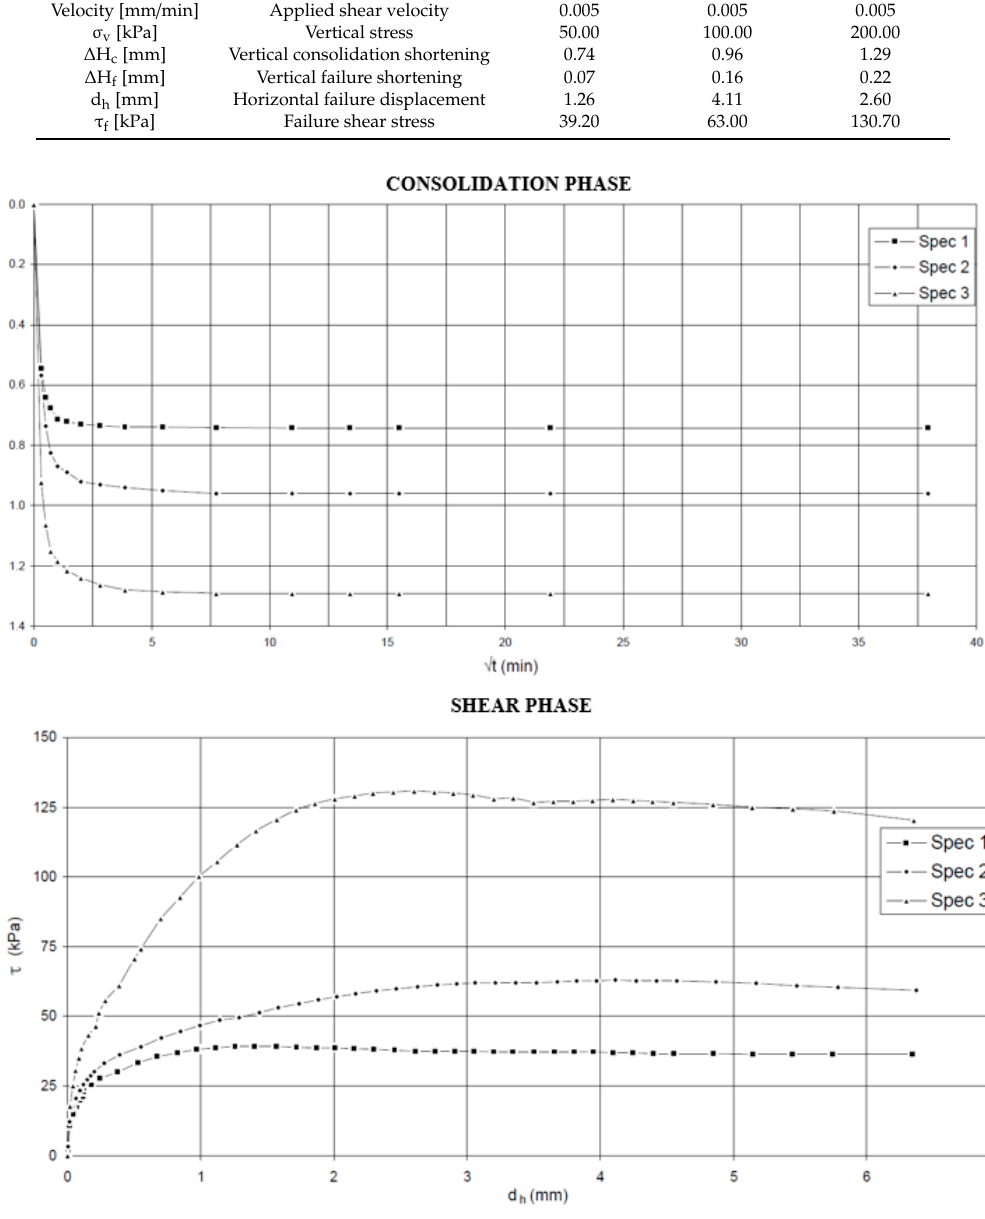
Table 1. Direct shear test and specimens details.